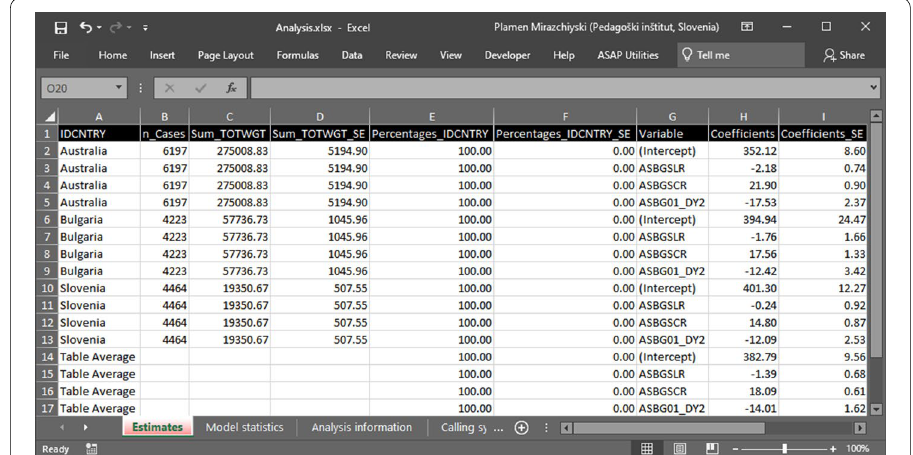
Fig. 4 Partial output from the lsa.lin.reg